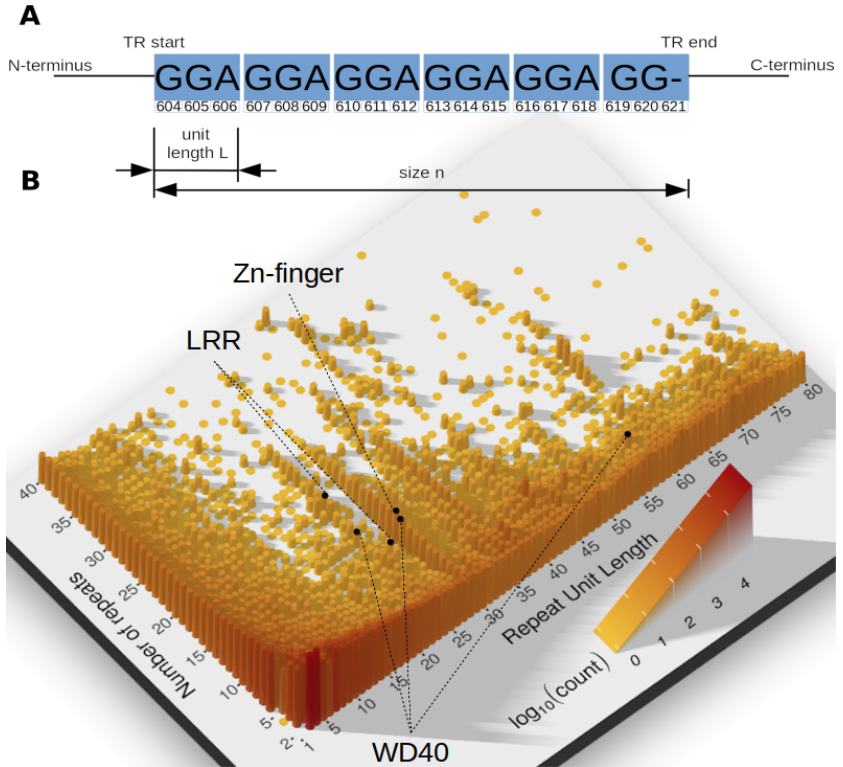
Figure 1. ( A ) An example tandem repeat (UniProtKB entry ID = A7TKR8) of size n = 6 units, each of L = 3 amino acids, in a head-to-head orientation. ( B ) Distribution of all annotated tandem repeats (TRs) as a function of TR unit length L ≤ 80 and number of repeat units n ≤ 40. Darker color and increased pillar height indicates a larger number of TRs. Most TRs has small TR units. Yet, there is a visibly high amount of domain TRs (25 < L < 50), and with certain unit length, e.g., L = 28, mostly zinc-finger